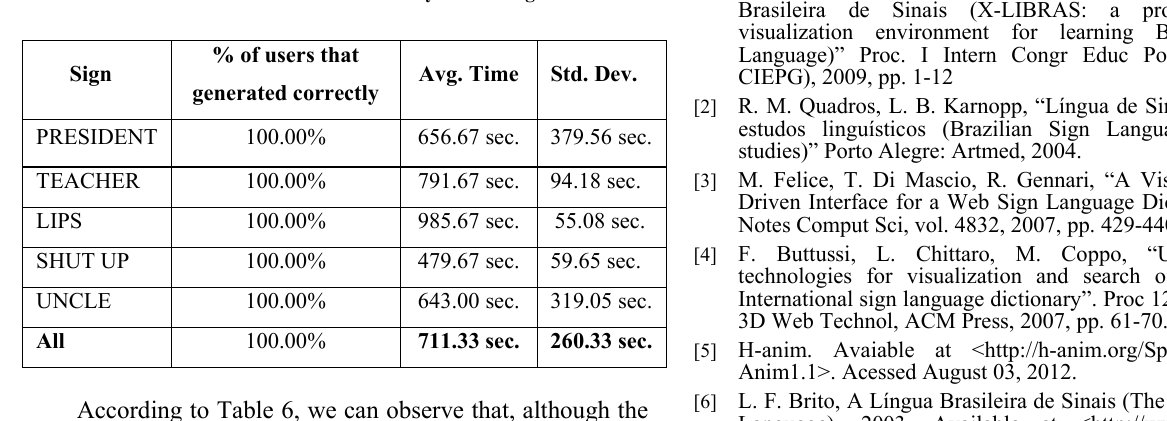
Table 6 – Effectiveness and efficiency of 3D